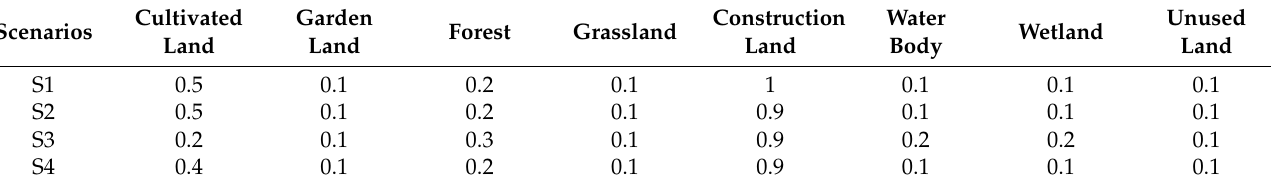
Table 4. The neighborhood factor parameters.